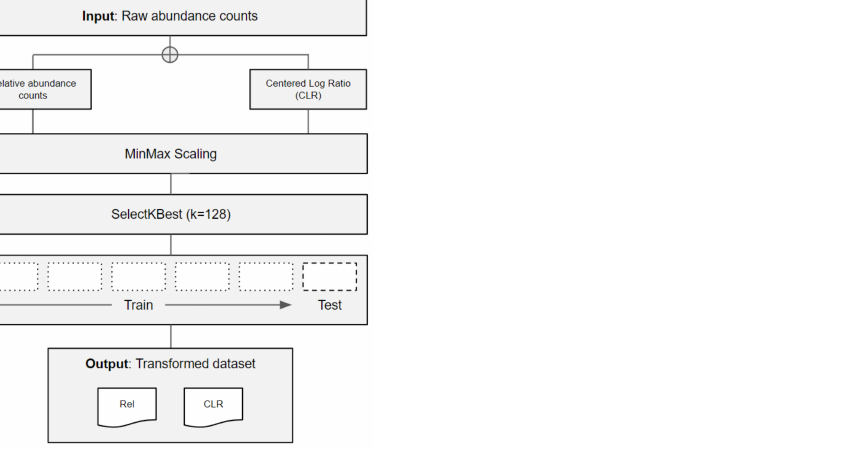
Figure 1. Data pre-processing flow from raw abundance counts input data to the transformed datasets used in classification